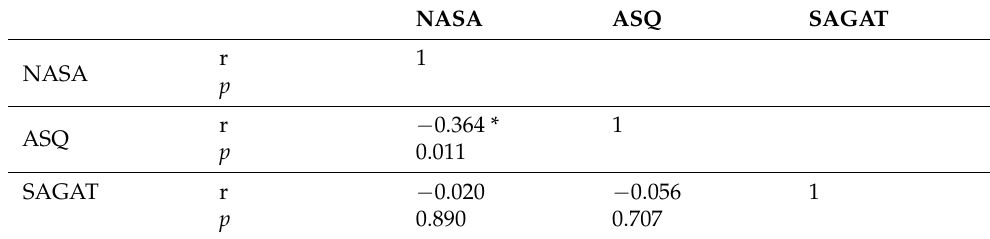
Table 3. Results of Pearson correlation analysis.